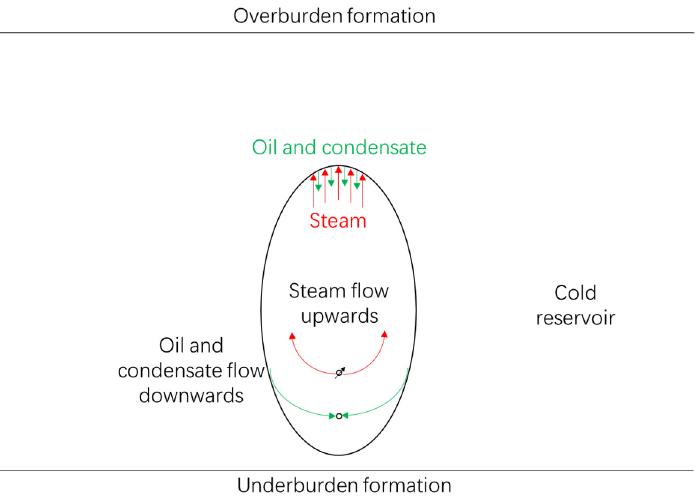
Figure 1. The cross-section of a steam chamber during the ramp-up phase of a typical SAGD oper- ation.